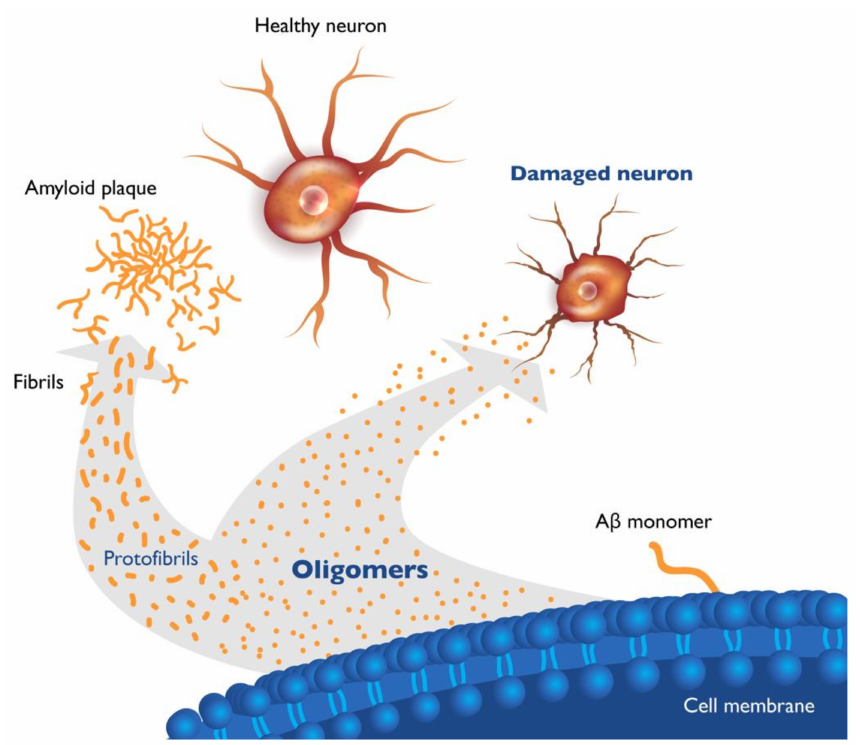
Figure 1. Beta amyloid species in brains of Alzheimer’s patients. Cleavage of amyloid precur- sor protein in neuronal membranes produces amyloid monomers. Misfolded beta amyloid (A β ) monomers aggregate into soluble oligomers of various lengths (dimers to dodecamers) and soluble protofibrils (large oligomers). Oligomers further aggregate into insoluble fibrils and plaque. Soluble A β oligomers, which are highly toxic to neurons and synapses, are considered upstream triggers of Alzheimer’s disease (AD)